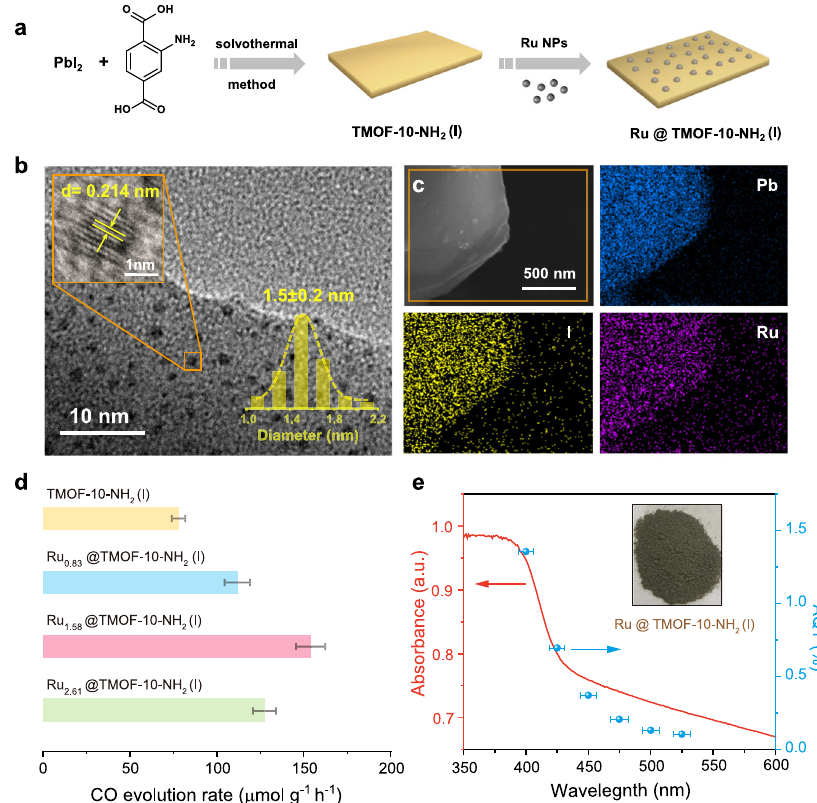
Fig. 7 | Synthesis and CO 2 photoreduction performance of Ru@TMOF-10- NH 2 (I). a Schematic presentation for synthesis of Ru@TMOF-10-NH 2 (I). b High resolution TEM images of Ru@TMOF-10-NH 2 (I), and the inset shows the size dis- tribution of Ru NPs and lattice spacing of 0.214nm for Ru NPs. c EDS mapping of Ru@TMOF-10-NH 2 (I). d CO evolution rate of TMOF-10-NH 2 (I), Ru 0.83